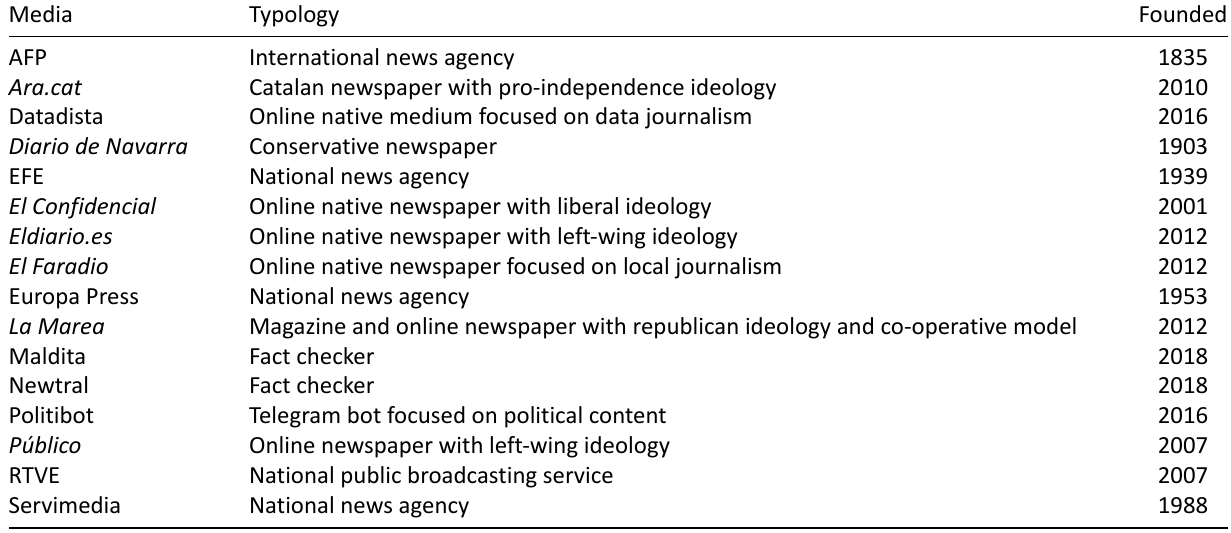
Table 2. Typology of the media participating in